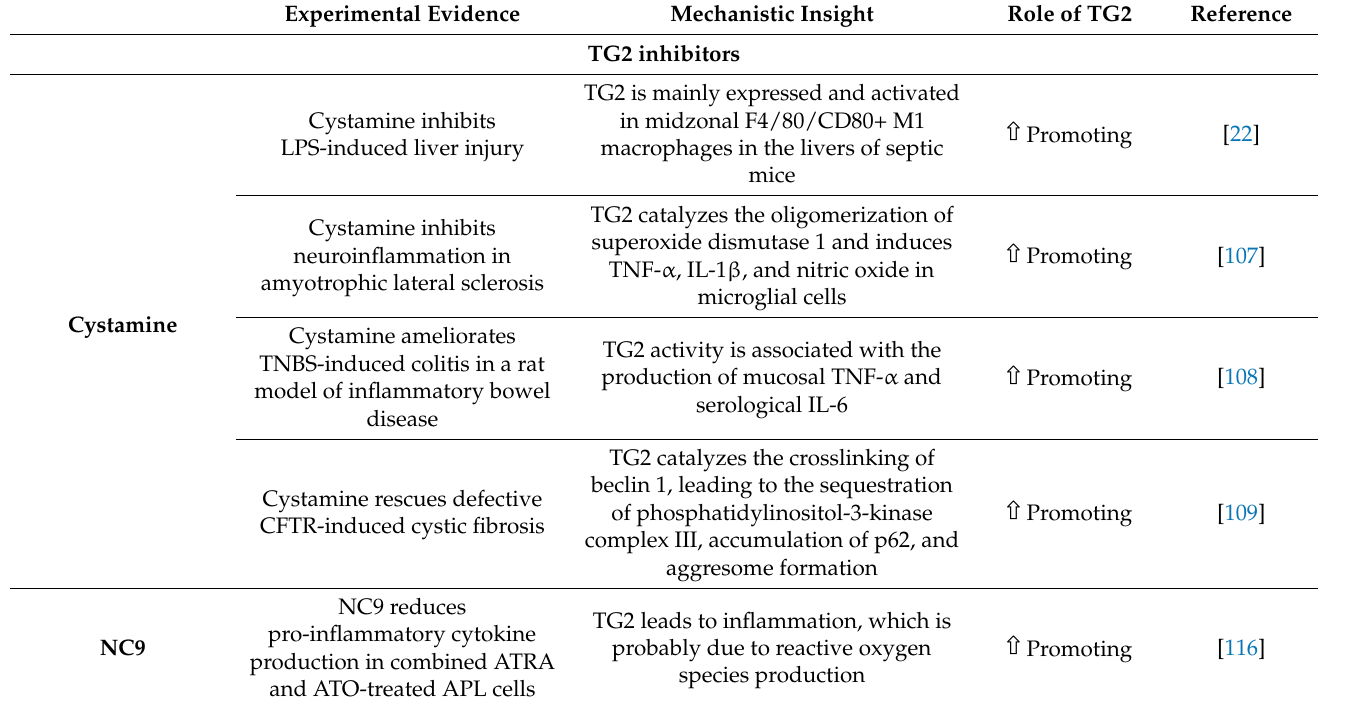
Table 1. Cont . Table 1. Evidence for genetic and pharmacological inhibition of TG2 during inflammation and sepsis.